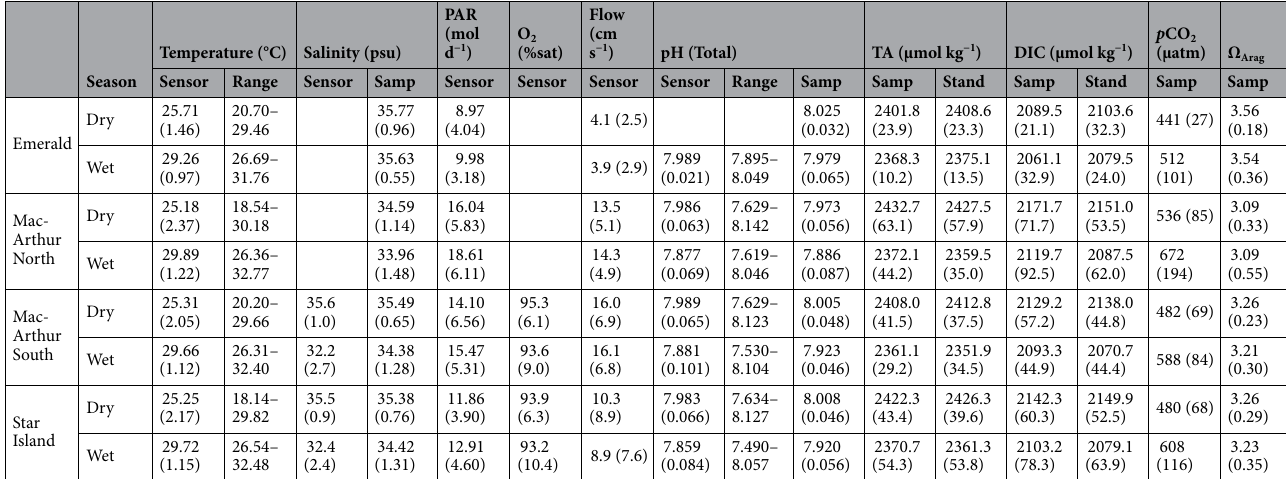
in the shallower, tidally-flushed urban sites than at Emerald (Table 1, Fig. 2). Currents in these sites were largely bi-directional, with MacArthur North experiencing the most uniform and MacArthur South experiencing the highest velocities (Fig. 3). Temperature and salinity fluctuations were observed to correspond to tide rather than time at inshore sites (Figs. S1–S3). While oxygen concentrations were not measured at Emerald, mean percent saturation was in the mid-90’s at the urban sites (Table 1), with high variability observed in the summer of 2020 (Fig. 2). There were significant differences in pH between sites and seasons (Fig. 2, Table 1, Table S2). Urban coral sites were generally more acidic than the natural offshore site, especially during the wet season when the pH Fig. S1). Total alkalinity (TA) and dissolved inorganic carbon (DIC) were correlated with salinity across all sites and seasons (Fig. S2) and no diel trends were observed (Fig. S3). A property-property plot of salinity-normalized nTA and nDIC revealed a significant linear relationship with a slope of 0.76 (Fig. S4). Extremes in these param- eters were observed primarily at the inshore urban sites, with lower values in the wet season and higher in the dry (Fig. S4). While TA and nTA were significantly different between seasons (higher in dry), no difference was detected between sites (Table 1, Table S2). DIC, however, was significantly different across sites and seasons (higher in dry), while nDIC was only significantly different across seasons (Table 1, Table S2). These parameters contributed to significant differences in the calculated partial pressure of CO 2 ( p CO 2 ) across sites and seasons, with higher values observed at inshore urban sites during the wet season, and the most extreme of which was MacArthur North (dry 536 ± 85, wet 672 ± 194 µatm; Table 1, Table S2). The saturation state of aragonite (Ω arag ) was significantly different across sites, but not seasons, with the highest values at Emerald Reef (dry 3.56 ± 018, wet 3.54 ± 0.36) and lowest values at MacArthur North (dry 3.09 ± 0.33, wet 3.09 ± 0.55; Table 1, Table S2). With respect to nutrients, Si and NO 2 were significantly different across sites and seasons, with higher values typically measured at inshore urban sites (Table 2, Table S3). At these sites, however, SI and NO 2 generally had mirrored behavior, with the wet season characterized by higher SI and lower NO 2 (Table 2, Table S3). The con- centration of NO 3 was significantly different across sites, but not seasons, with higher values again measured at inshore urban sites (Table 2, Table S3). As with the seasonal trends of the other measured nutrients, NH 4 was higher during the wet season; however, there was no difference among sites in NH 4 (Table 2, Table S3). PO 4 was similar across all sites and seasons. N:P ratios ranged from 4.8 to 139.0 and were generally lower in the dry season (Table 2). Wet season values all suggested P limitation and means were greater than 120, with the exception of MacArthur North, which was 36.4. Benthic community. strates, which contributed to their linear nature (Fig. 4). Benthic communities were distinct at each of the four sites surveyed (PERMANOVA: F (Fig. 5, Table S4). The relative cover of sediments was the most influential benthic class between all pairwise comparisons of site (percent variation ranging from 18.2 to 23.3%), with turf algae the next most influential